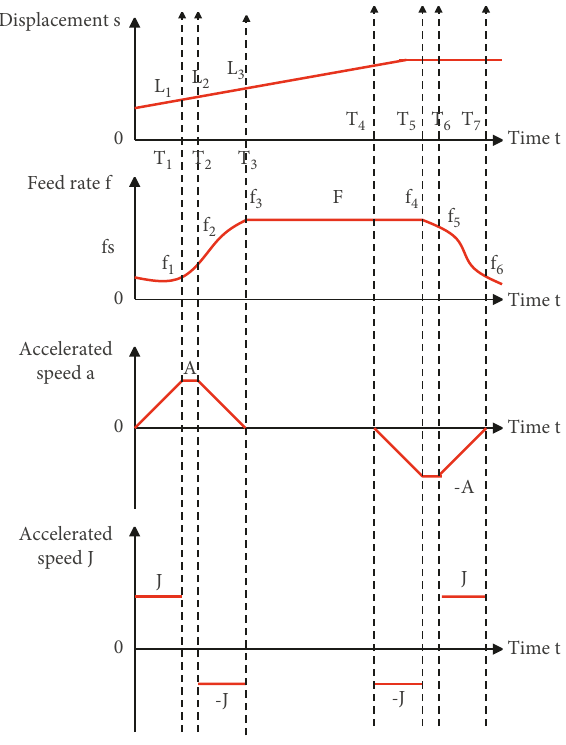
Figure 5: S -type acceleration and